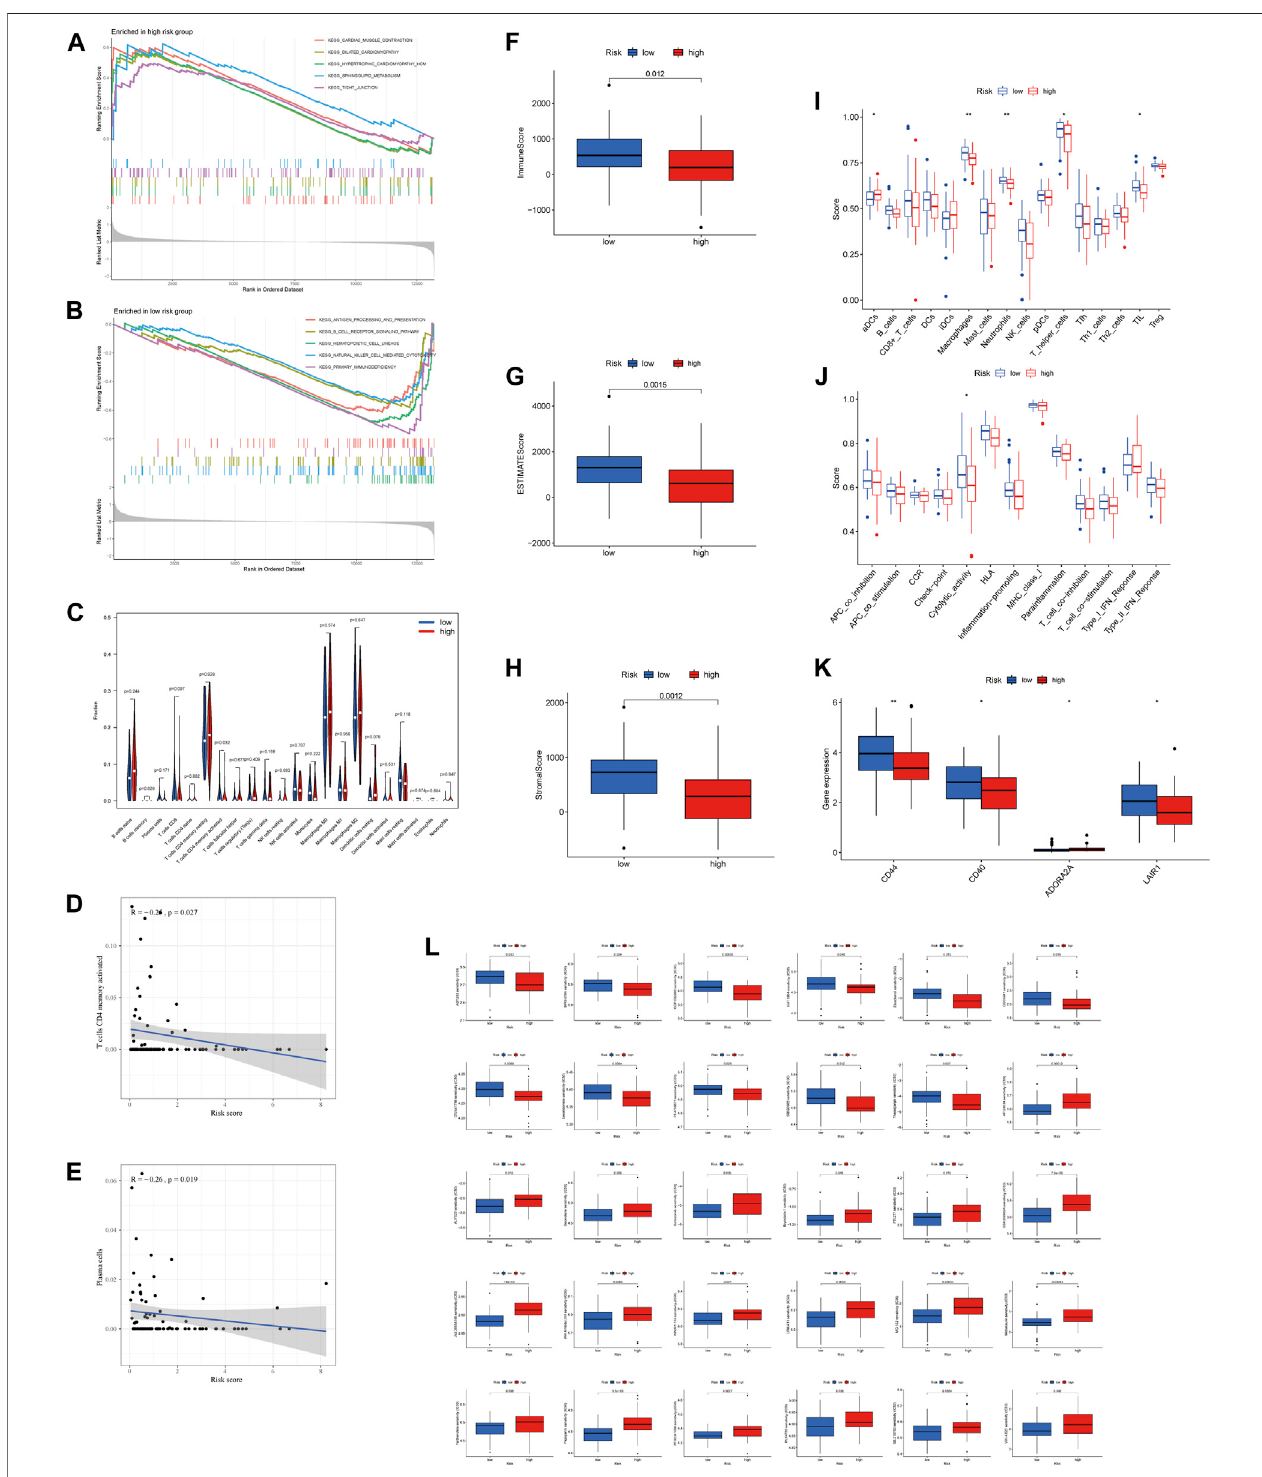
FIGURE 5 | Immune signature in the high-risk and low-risk groups. (A, B) GSEA analysis in the high-risk and low-risk groups, respectively. (C) Expression of immune cells between two groups. (D) Relationship between risk score and T cell CD4 memory activation. (E) Relationship between risk score and plasma cells. (F – H) Differential expression of TME scores (immune scores, ESTIMATE scores, and stromal scores) between risk groups. (I) Differential expression of cell in fi ltration between riskgroups isbasedon thessGSEA scores. (J) Immunefunctional differences betweenriskgroups arebased onthessGSEA scores. (K) Differentialexpression of immune checkpoints between risk groups. (L) Sensitivity performance of 30 drugs in the high-risk and low-risk groups.